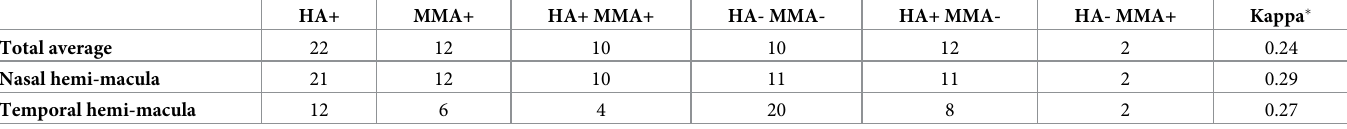
Table 2. Number of eyes with microcystic macular abnormality (MMA) and hyporeflective abnormality (HA) on confocal infrared photography in 34 eyes with temporal hemianopia and band atrophy of the optic nerve. HA+ MMA+ HA+ MMA+ HA-